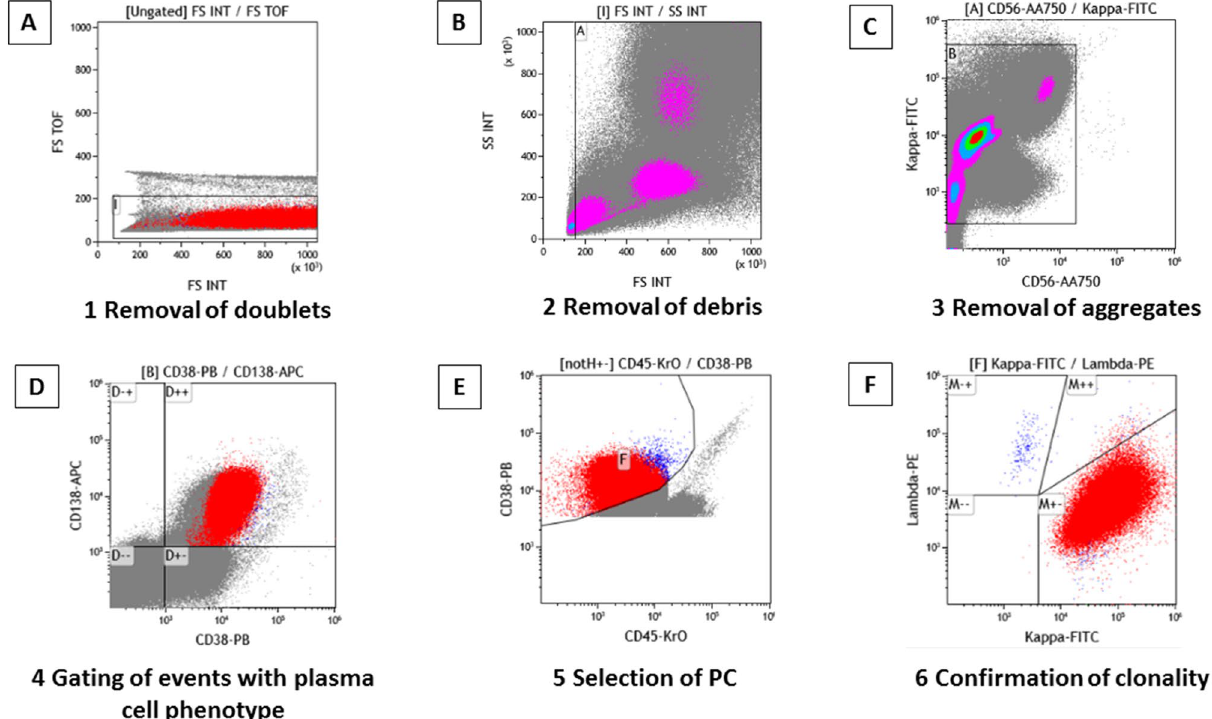
Figure 3. Overview of the gating strategy of plasma cells (PCs) and confirmation of clonality of abnormal PCs by DuraClone method. Light scatter characteristics are used to exclude doublets with high time of flight (TOF) ( A ), debris with lower scatter peak than lymphocytes ( B ) and aggregates with high fluorescent events with Ig-κ- FITC and CD56-APC-A750 ( C ). All possible PCs are captured by gating CD38 + and CD138 + bright events ( D ). PCs are selected with CD38 high events using CD45 ( E ). Confirmation of clonality by Igκ and Igλ ( F